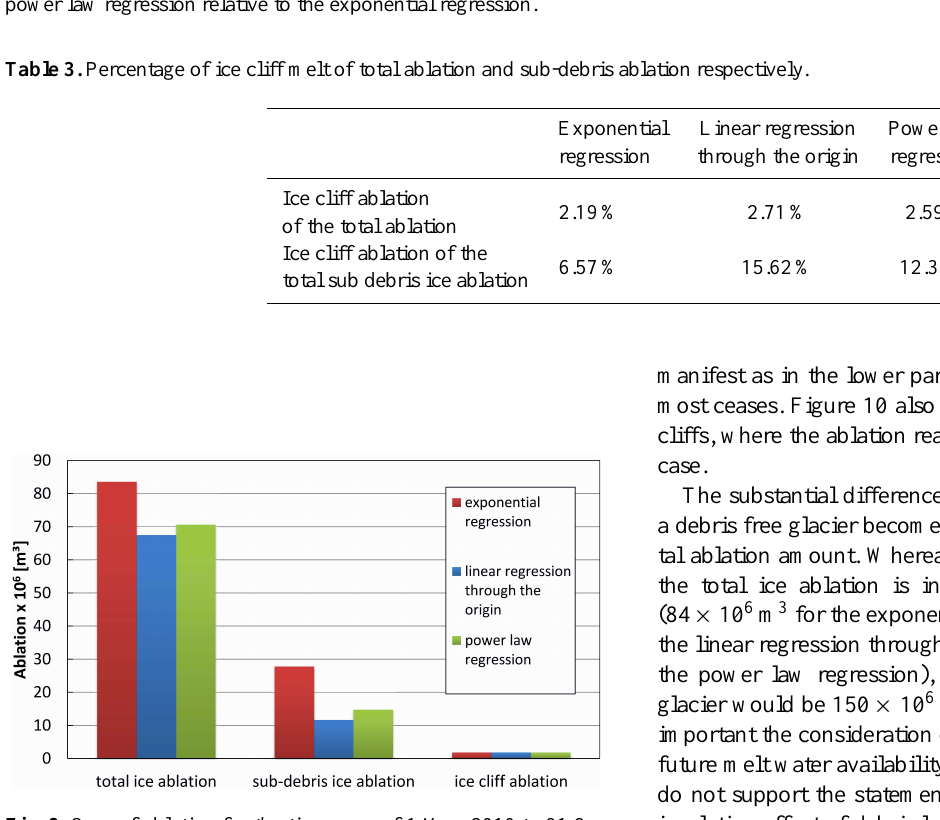
Fig. 8. Sum of ablation for the time span of 1 May 2010 to 31 Oc- tober 2010 for different debris cover thickness